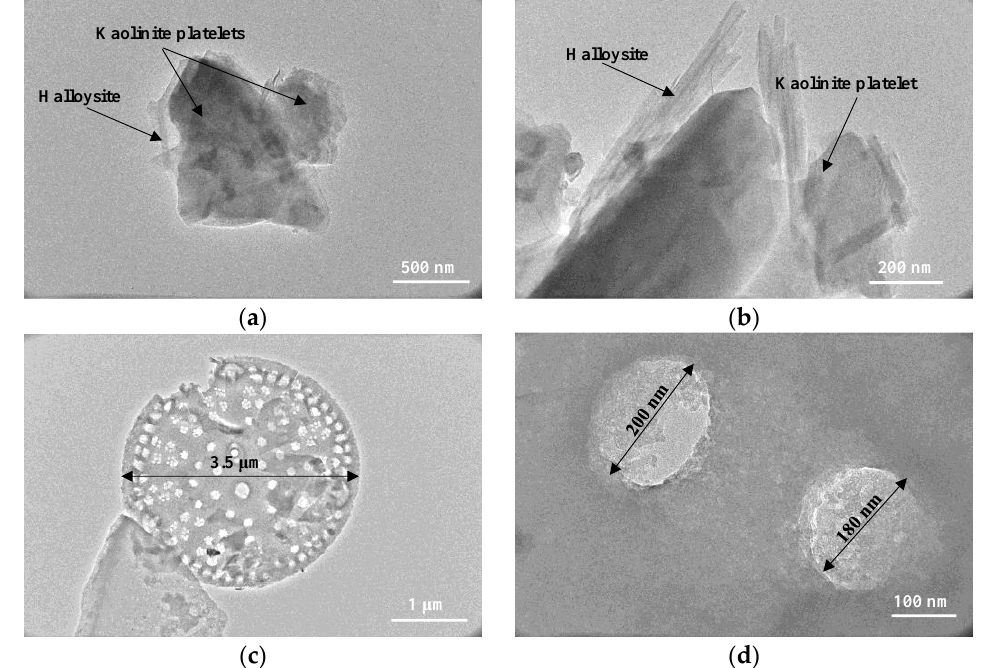
Figure 4. Transmission electron microscopy images of ( a ) kaolin (15,000× magnification); ( b ) kaolin (40,000×); ( c ) diatoms (8000×); and ( d ) diatoms (80,000×).